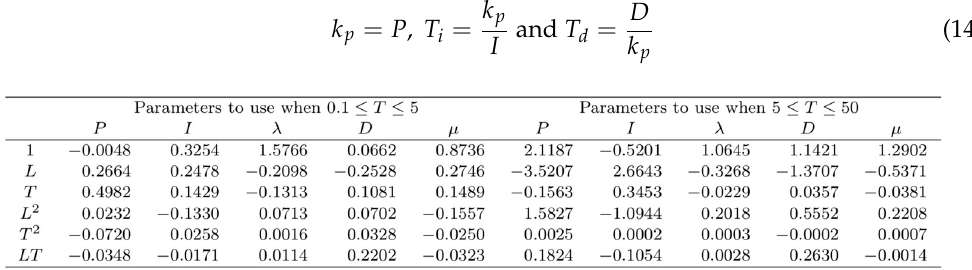
Figure 4. Parameters for the first set of tuning rules for S-shaped response processes ( P = k p , I = k p / T i , D = k p T d ) [32].